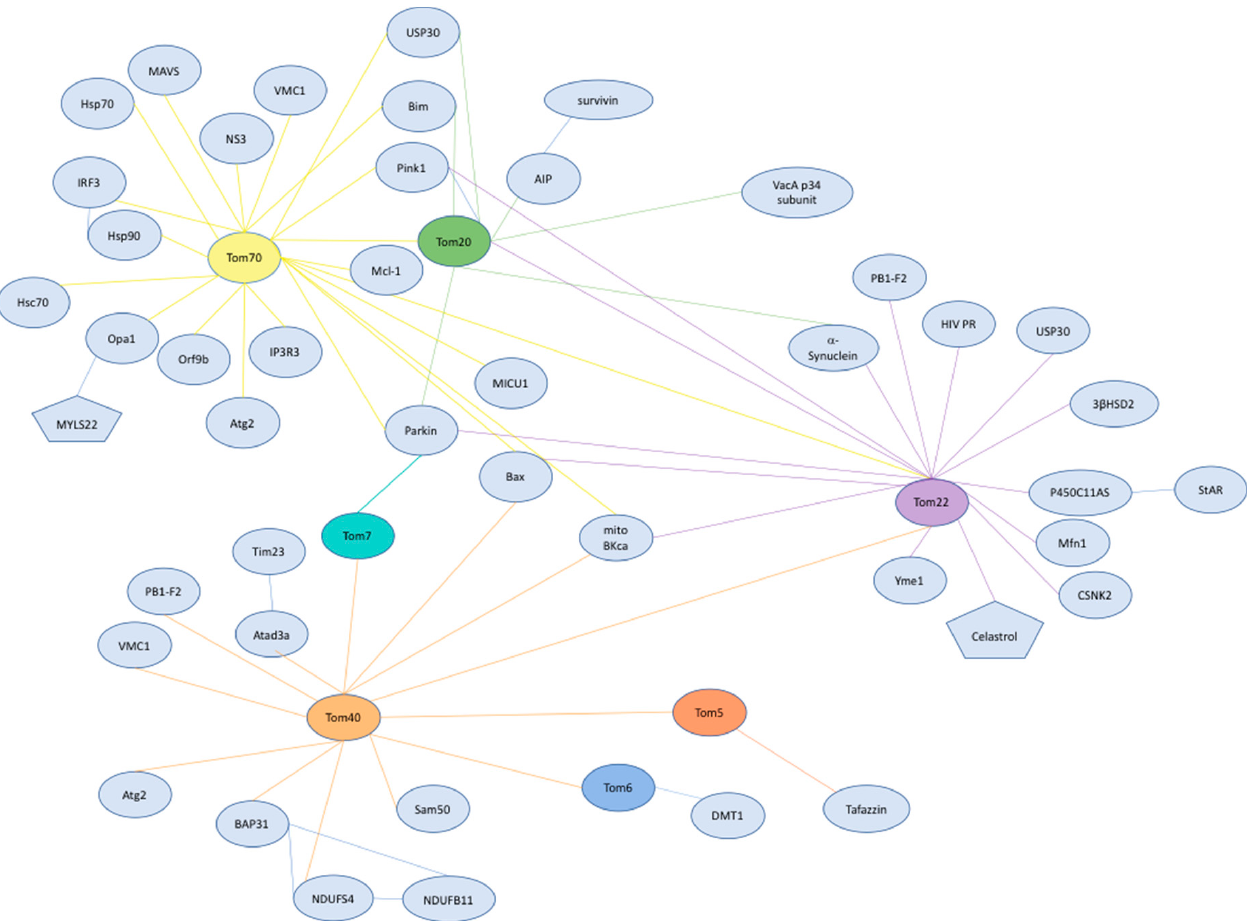
Figure 2. TOM complex interactions. Interaction map of TOM complex subunits demonstrating the vast network that has functions in import, immunity and infection, mitochondria-endoplasmic reticulum contact sites (MERCS), cancer, metabolism, apoptosis, and neurodegenerative diseases. Ovals represent proteins, and pentagons represent small molecules. TOM complex subunits are colored for ease of understanding. Tom40 (orange), Tom22 (purple), Tom5 (vermillion), and Tom6 (light blue), Tom20 (green) and Tom7 (seafoam